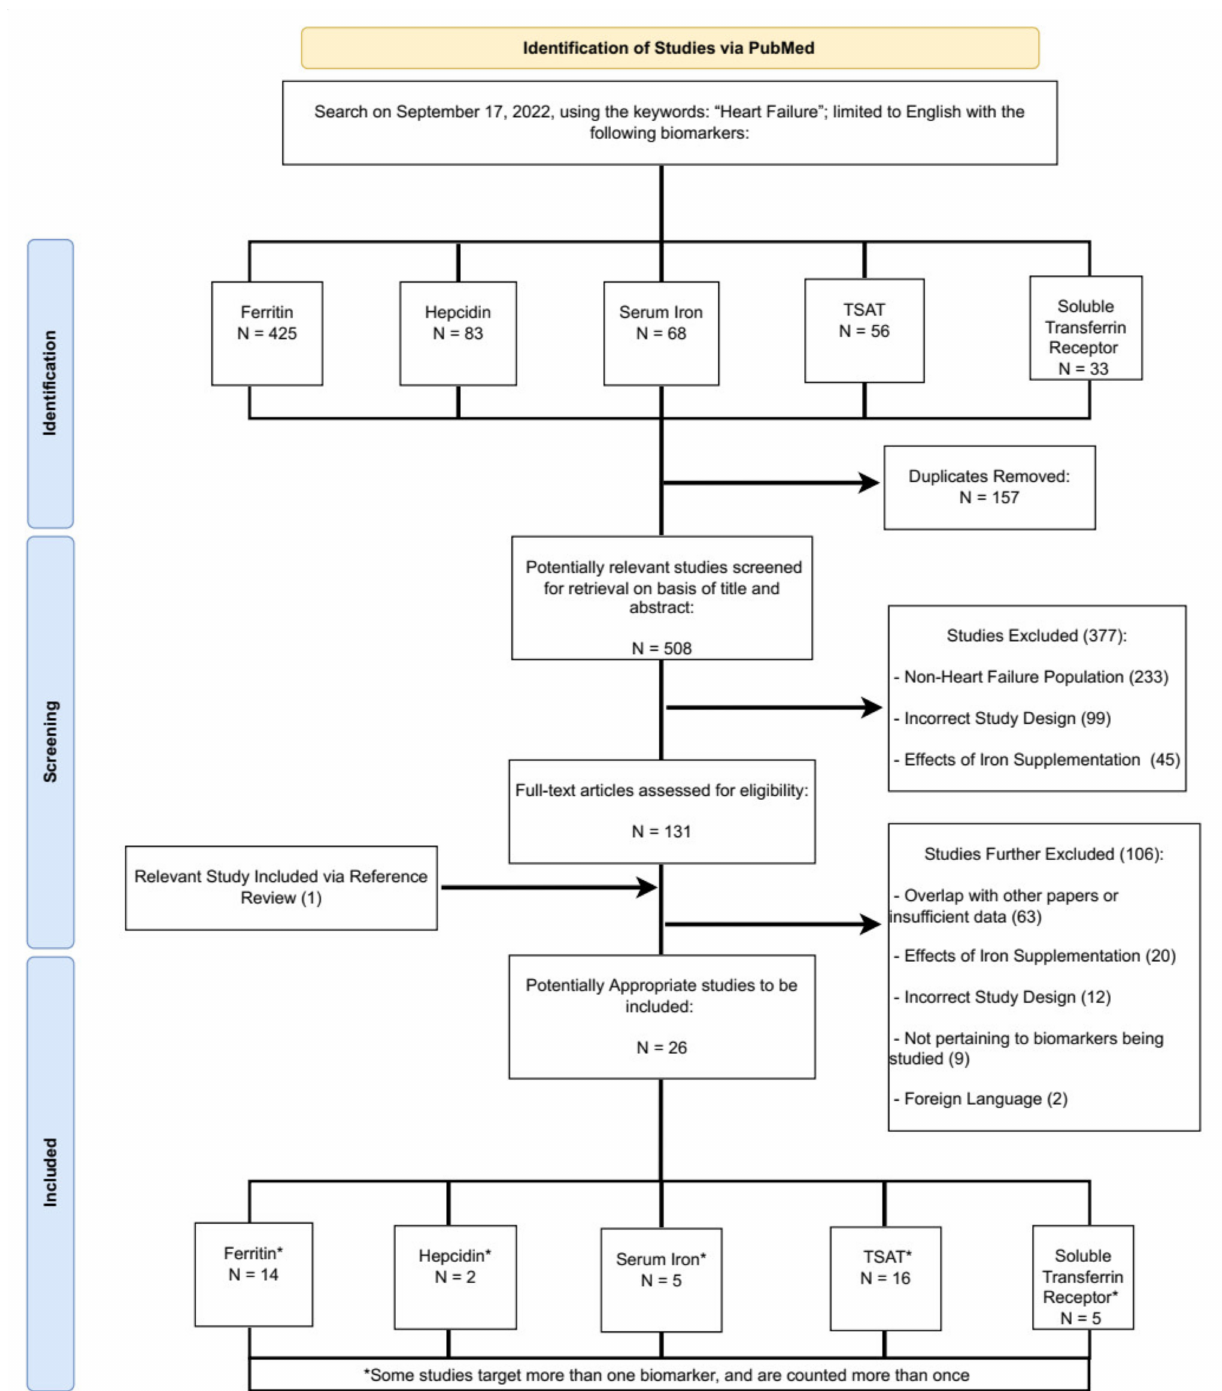
Figure 1. Summary of the study inclusion/exclusion